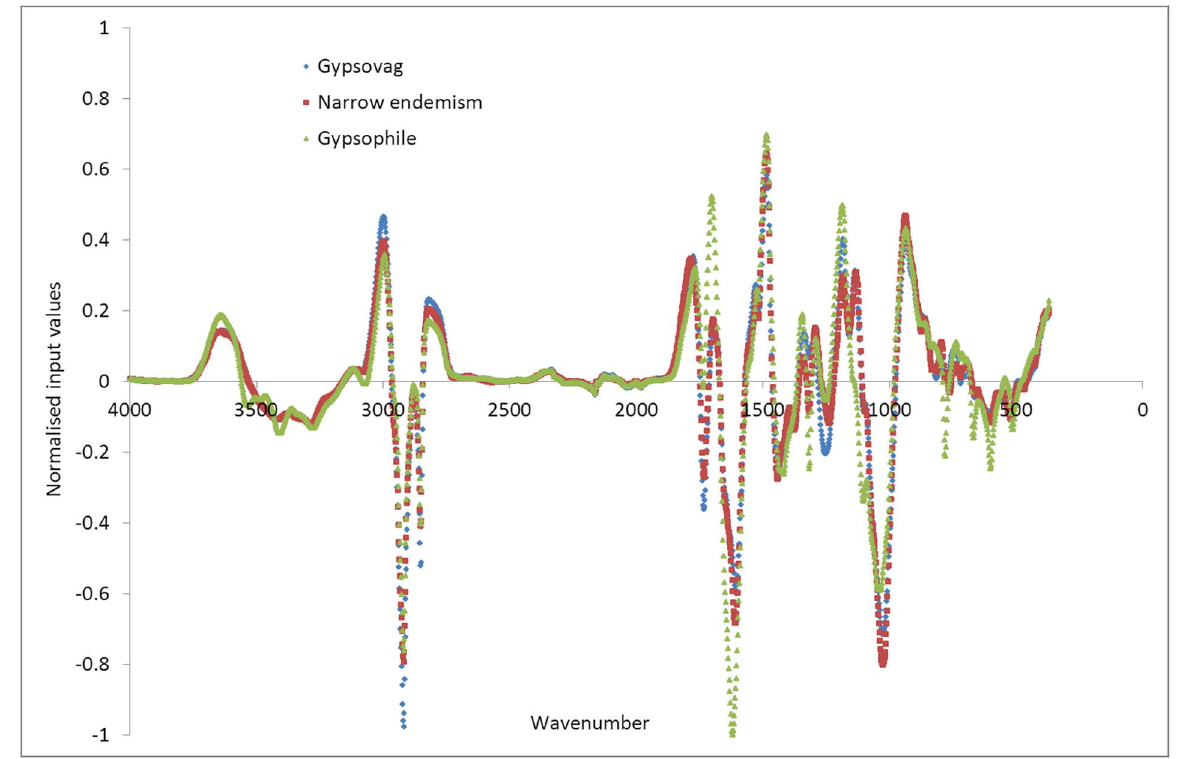
Figure 4. Input datasets averaged over each of the gypsum plant types (gypsovags in blue, narrow gypsum endemisms in red, wide gypsophiles in green), for the full wavenumber